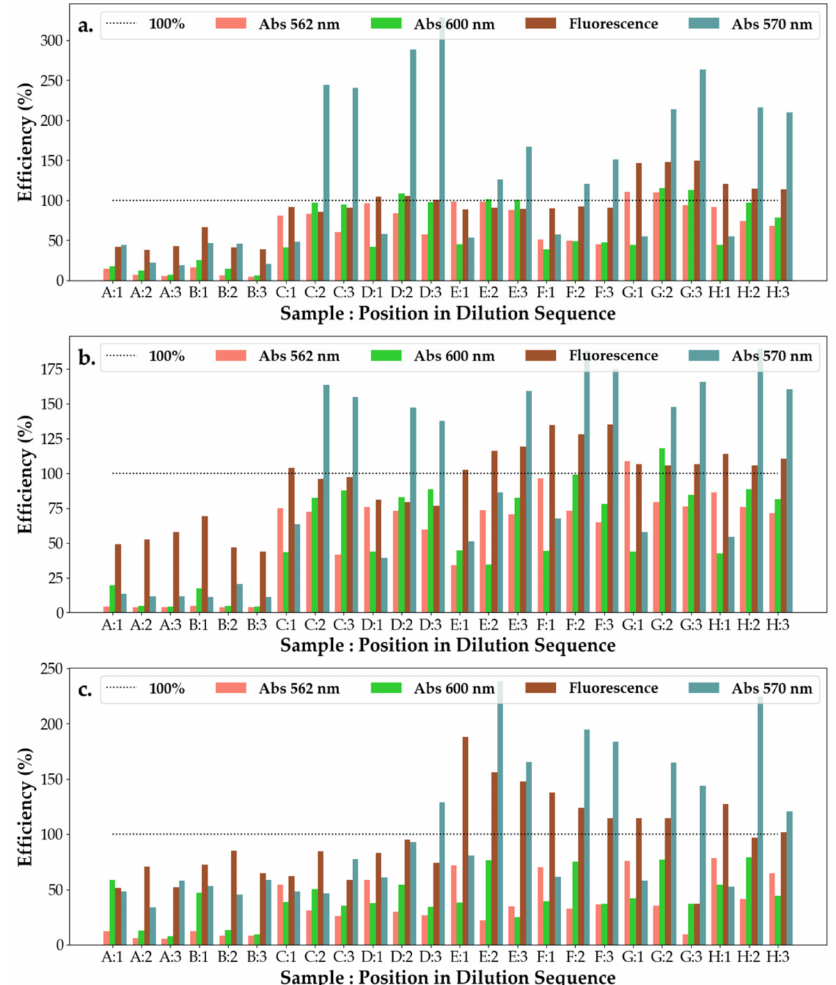
Figure 8. Efficiency of the antibacterial response ( η ) of the SAg/AuNP-WT samples at three levels of dilution tested against ( a ) Escherichia coli , ( b ) Pseudomonas aeruginosa and ( c ) Staphylococcus aureus . Samples A–H represent the following solutions tested against the bacteria: A—SAuNPs-WT 1S; B—SAgNPs-WT 1S; C— Salix Alba extract; D— Salix Alba extract; E—SAuNPs-WT 7S; F—SAuNPs-WT 10S; G—SAuNPs-WT 7S; and H—SAuNPs-WT 10S, as also shown in Figure